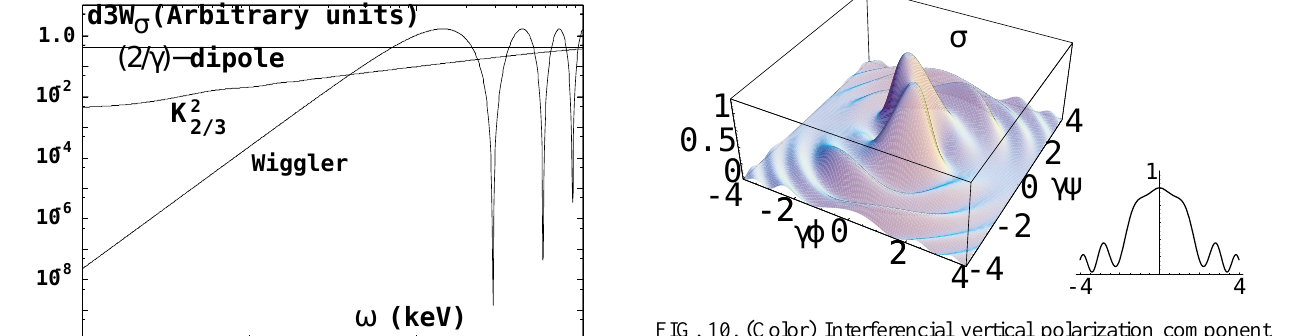
FIG. 10. (Color) Interferencial vertical polarization component from the so-tailored “edge–( 2 (cid:4) g )-dipole–edge” wiggler l (cid:2) 10 2 6 m), and (right plot) a gf cross section of it at gc (cid:2) FIG. 8. Interferencial spectrum of the wiggler s component 0 . Comparison with the single dipole radiation (second plot in in the forward direction [Eq. (22) with w (cid:2) c (cid:2) 0 ], together Fig. 7) shows that the forward density of the ( 2 (cid:4) g ) dipole is with, for comparison, spectra from the central ( 2 (cid:4) g ) deviation fully dipole alone [Eq. (9) with K (cid:2) 1 ], and from the center of strong (cid:1) v (cid:2) shape [8] ]. dipole [classical K 2 2 (cid:4) 3